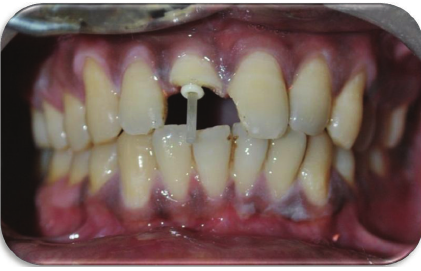
Figure 7: Post placement.